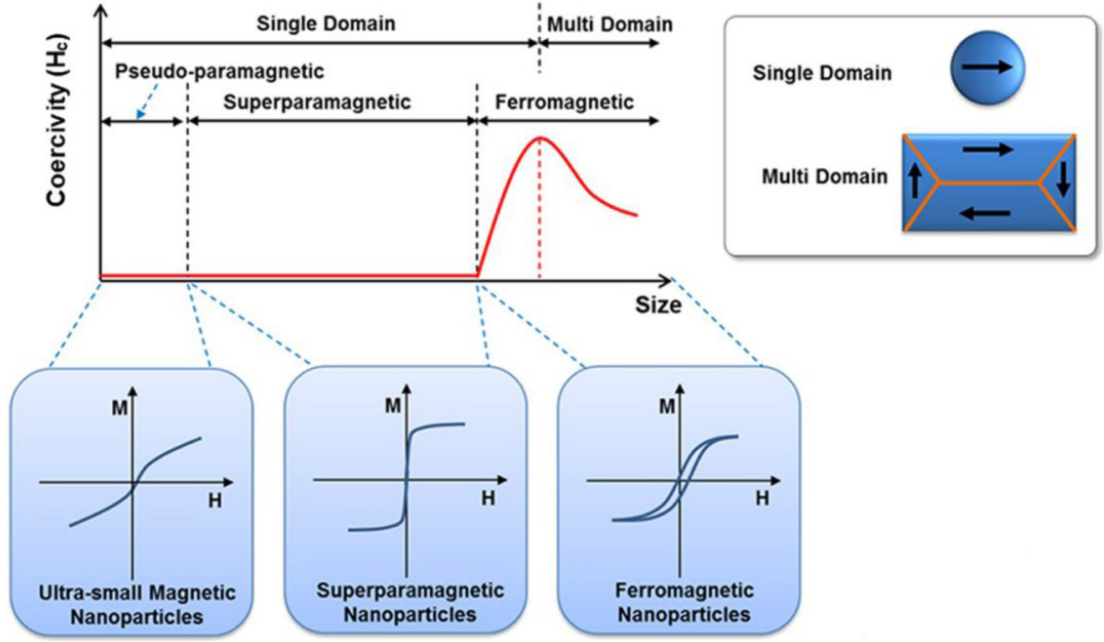
Figure 5. Overview showing the mechanism of thermal energy generation using magnetic nanomaterials. Visualization of typical hysteresis loops in a ferromagnetic/ferrimagnetic nanomaterial and a superparamagnetic nanomaterial and the dependence of the coercivity on the particle size. Adapted from [182], originally published under a CC-BY license.